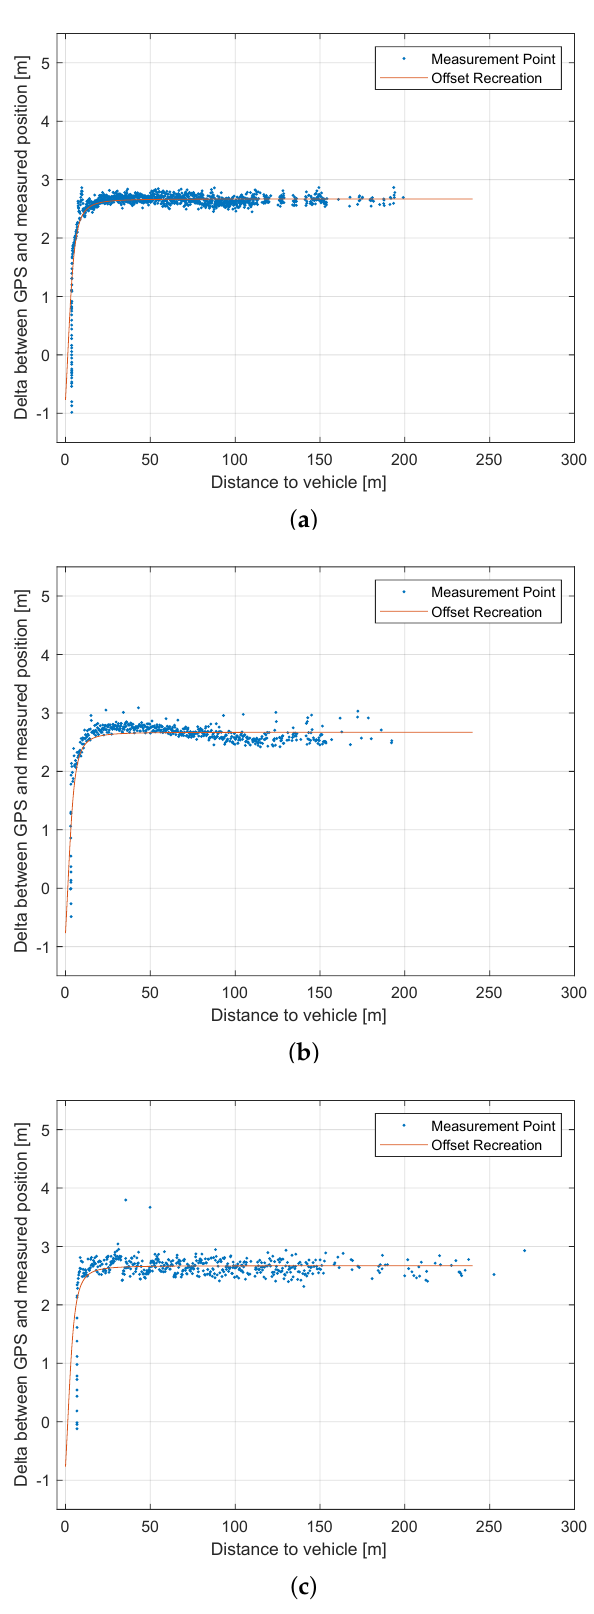
Figure 10. Results of Scenario 4. The difference between GPS and LiDAR measurement in relation to the distance is shown ( a ) Velodyne Velarray (1175 vehicle detections); ( b ) Robosense M1 (522 vehicle detections); ( c ) Livox Horizon (468 vehicle